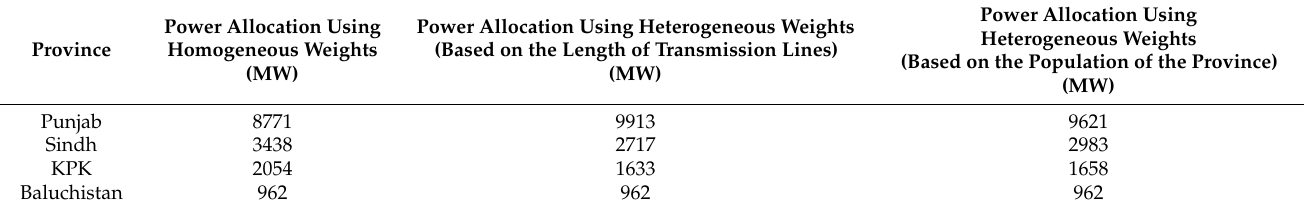
Table 4. Power allocation using Nash bargaining theory.